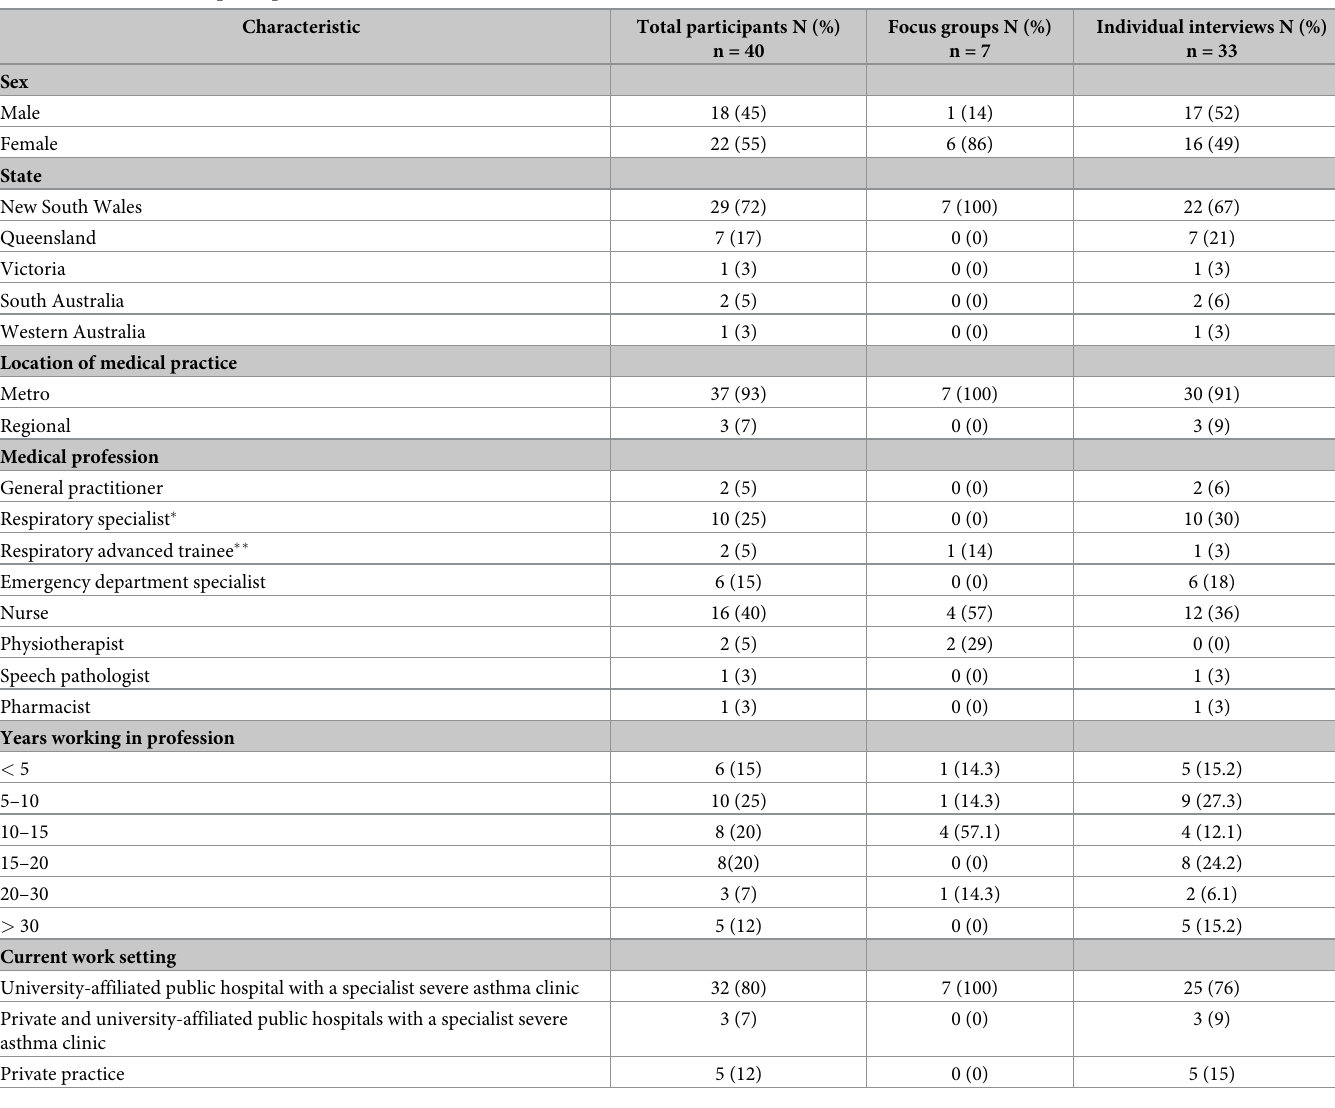
Table 2. Characteristic of